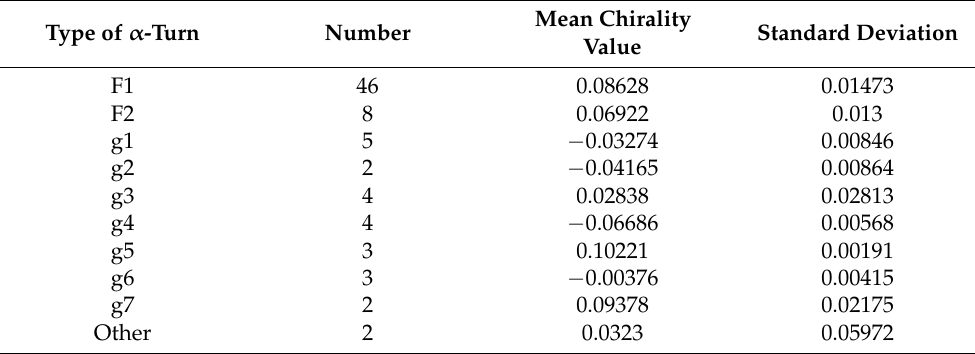
Table 1. Mean values of chirality and standard deviations for α -turns of various types [98], calculated using the method for evaluating the chirality of regular helical and irregular protein secondary structures.